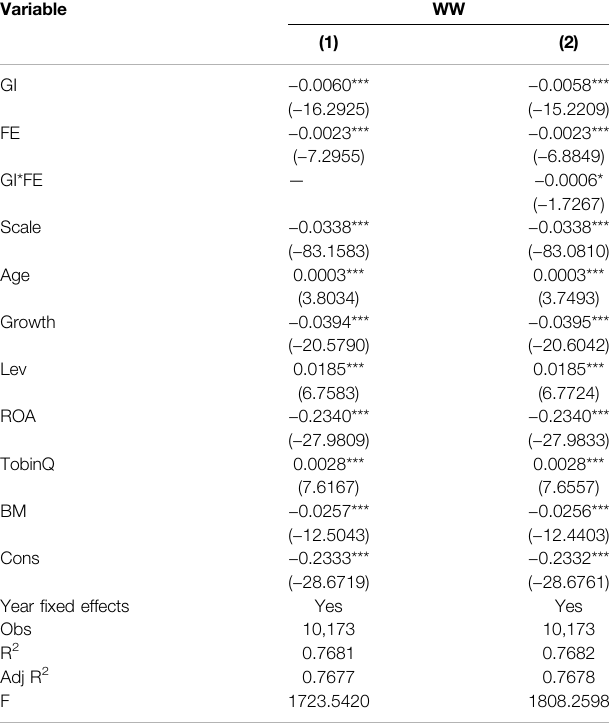
TABLE 8 | Robustness